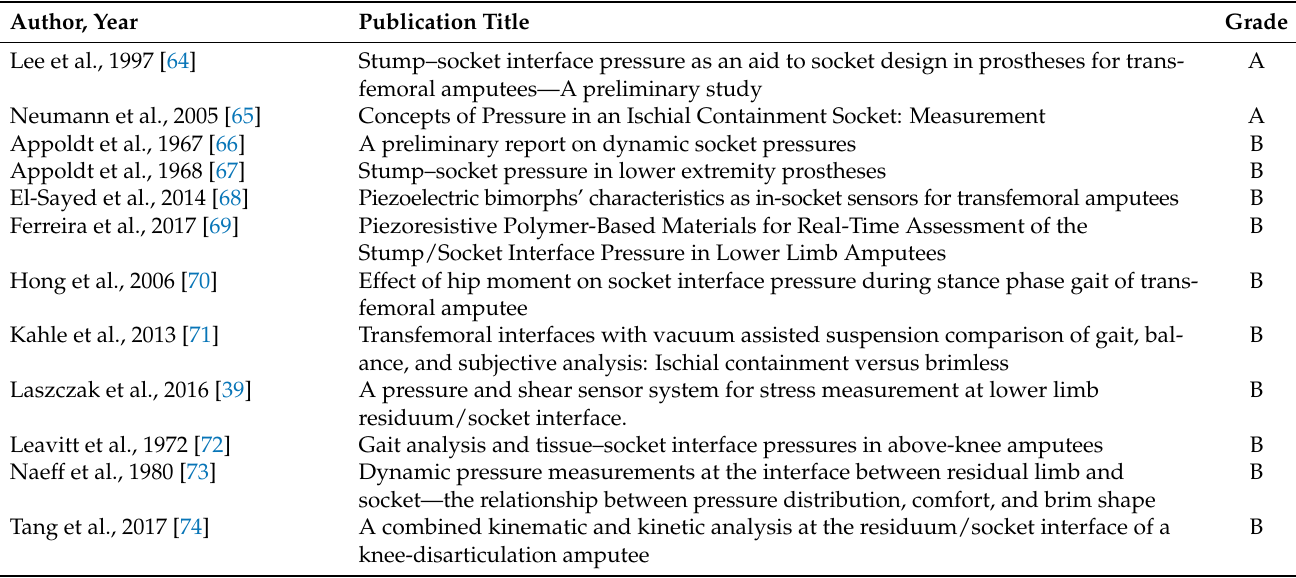
Table 4. Papers selected for data synthesis and their